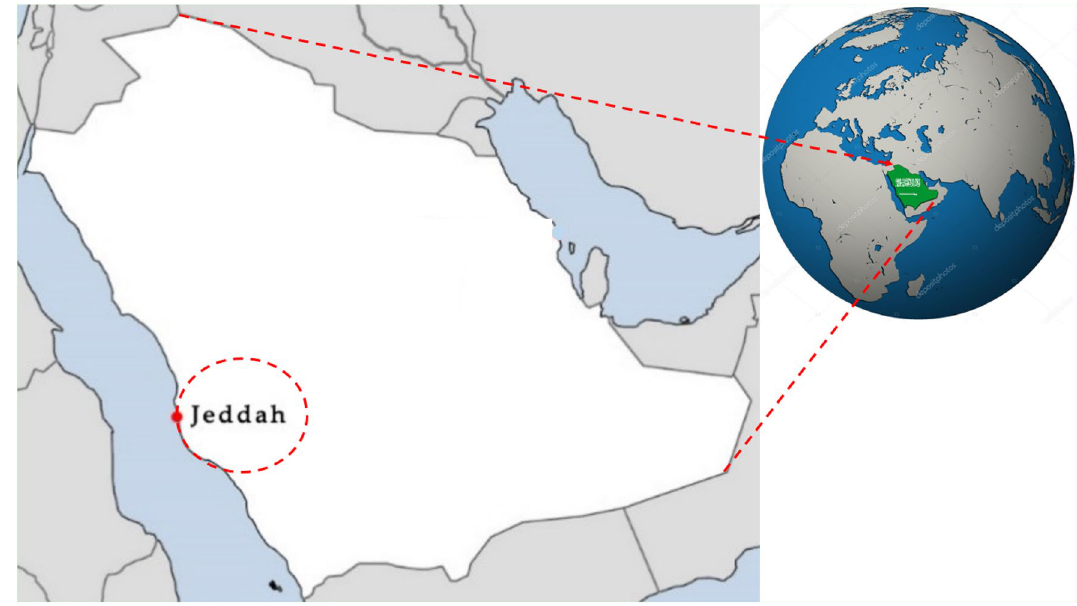
Figure 2. Location of Jeddah Region’s selected collection and transfer stations (Satellite imagery source: The National Map; http:// viewer. natio nalmap. gov/